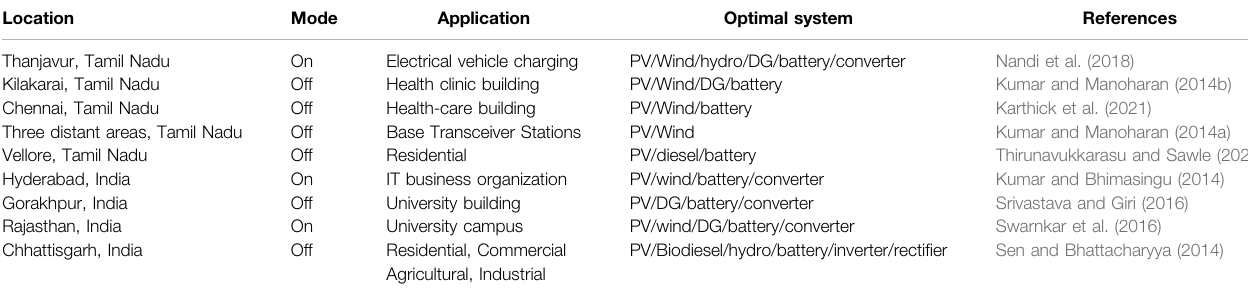
TABLE 1 | Case studies in the Indian scenario (developed by the author).